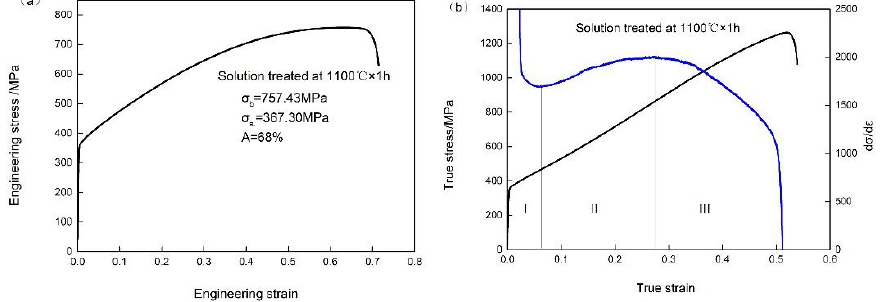
Figure 2. ( a ) The stress–strain curve of experimental steel; ( b ) the true stress–strain curve and work hardening curve of experimental